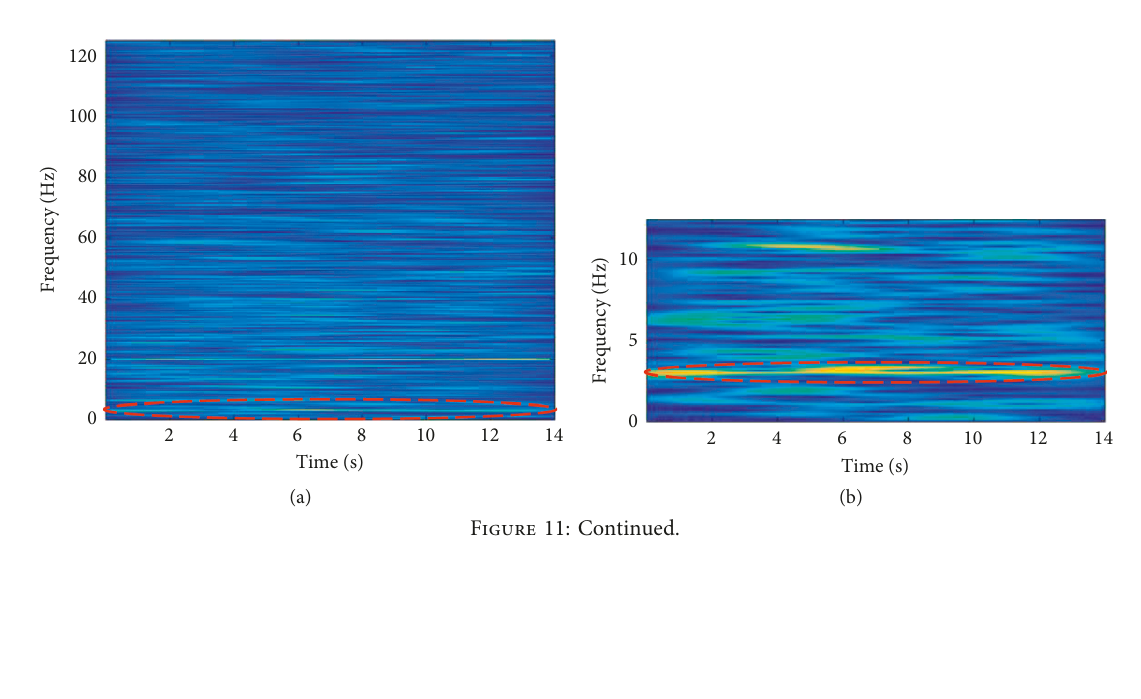
Figure 10: The filtered signals: (a) experiment 1 and (b) experiment 2.